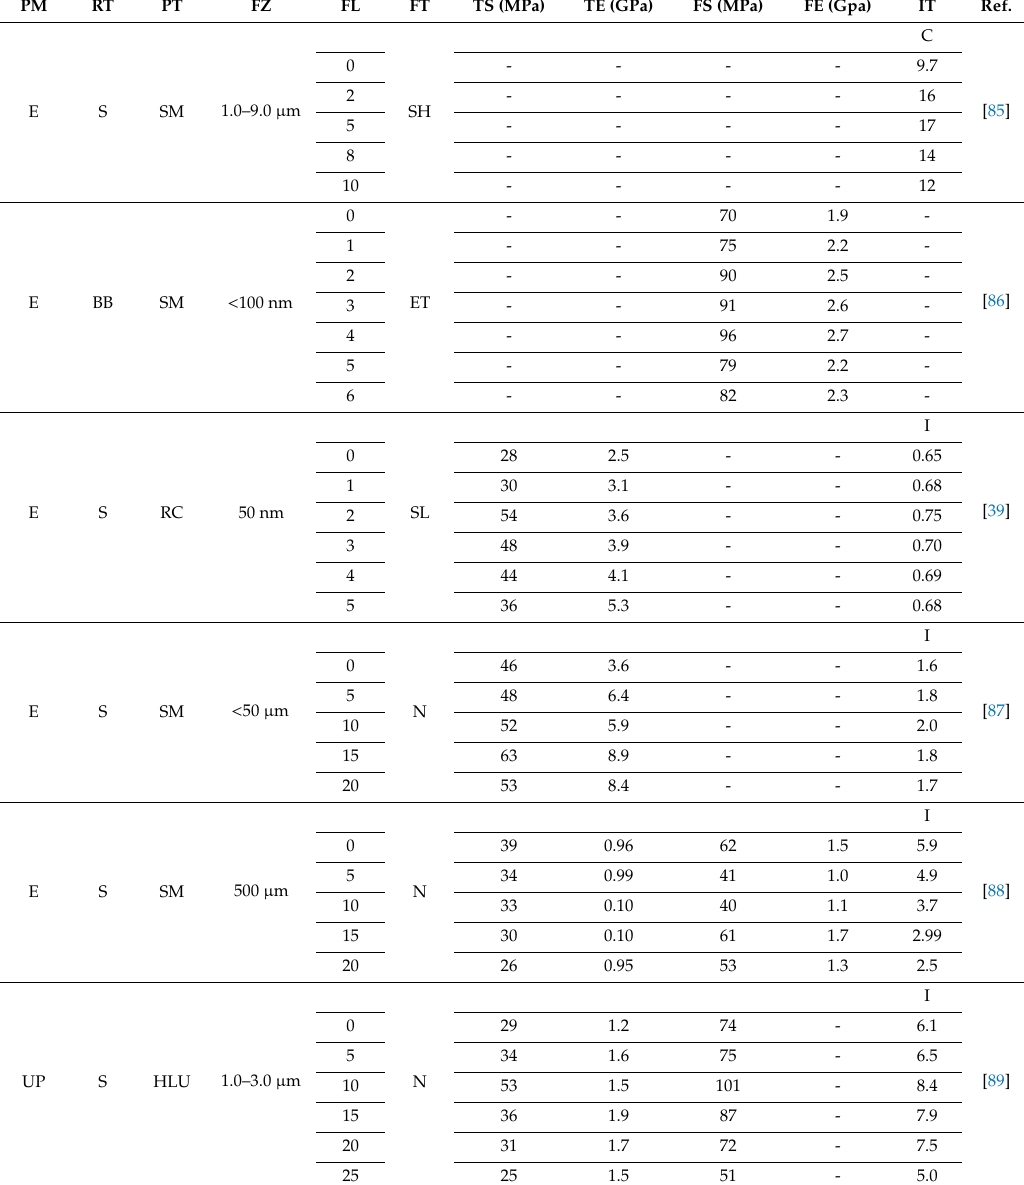
Table 7. Summary of thermoset polymers containing eggshell